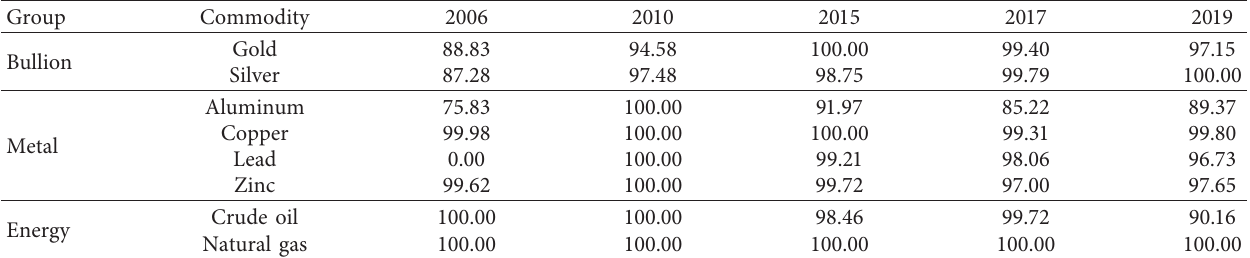
Table 3: Commodity wise total value of trade (%) in Multi Commodity Exchange Limited